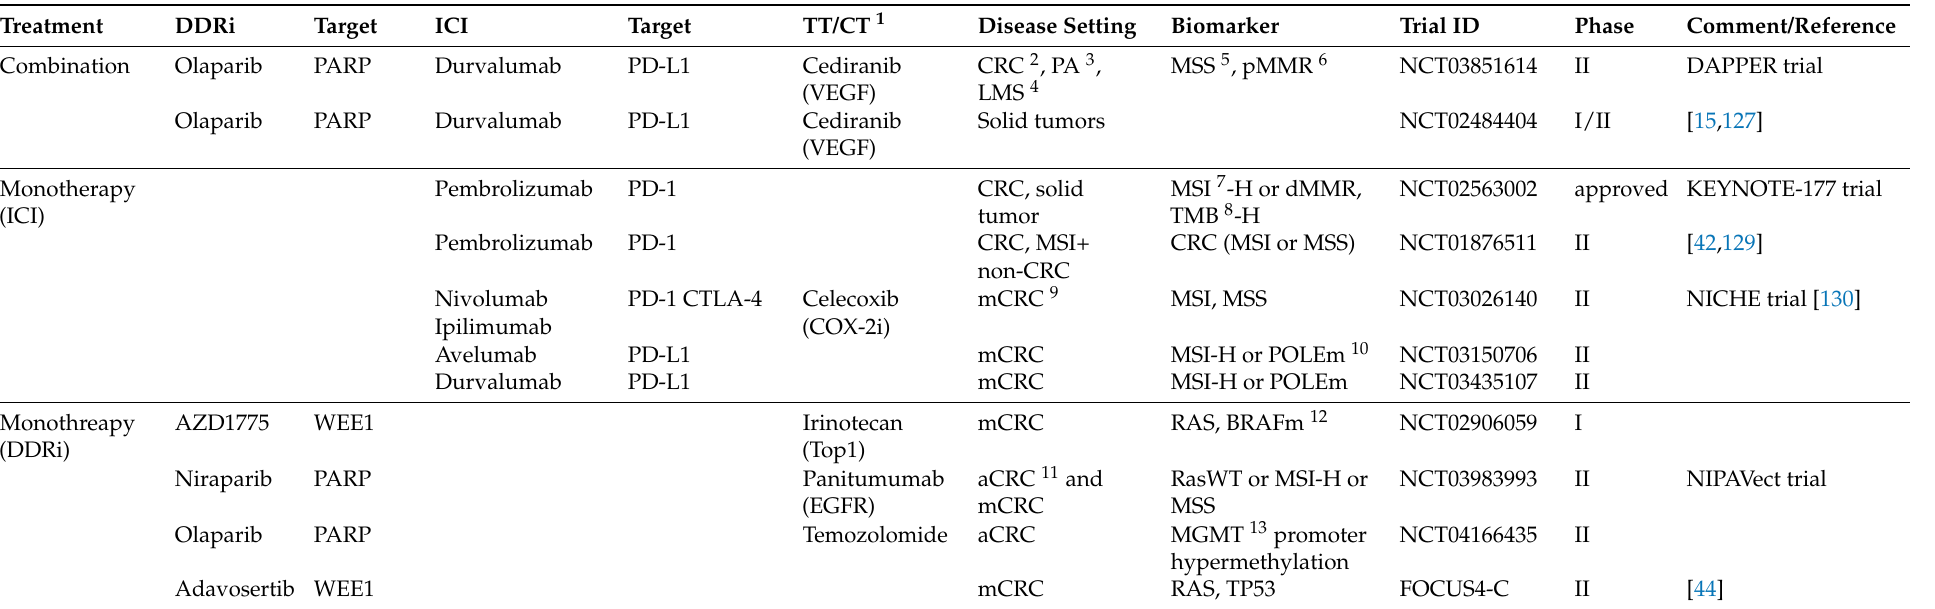
Table 2. Clinical trials of colorectal cancer using immunotherapy or synthetic lethality